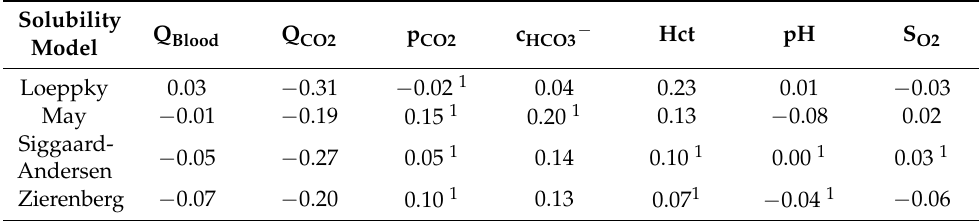
Table 2. Spearman correlation coefficients between average prediction error ( ε ) and selected parame- ters calculated for in vitro bovine blood trials and the four CO 2 solubility models.